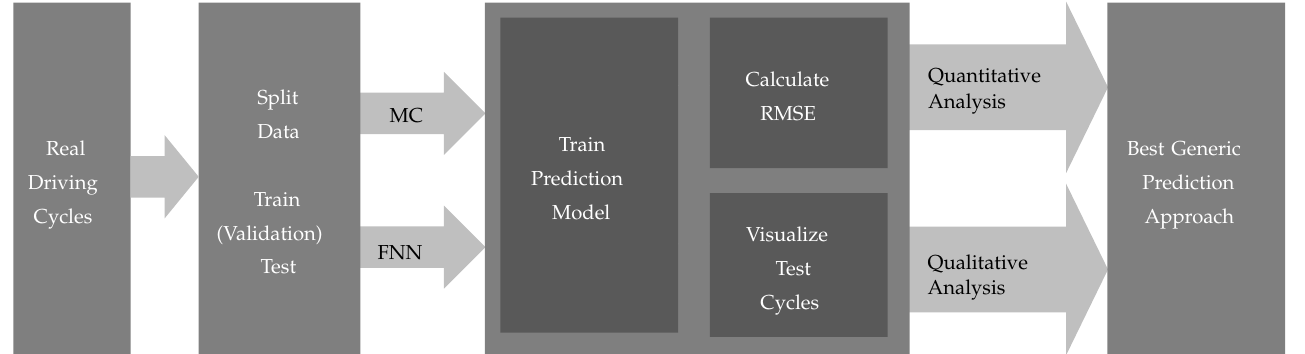
Figure 4. Applied methodology to determine the best generic prediction approach.